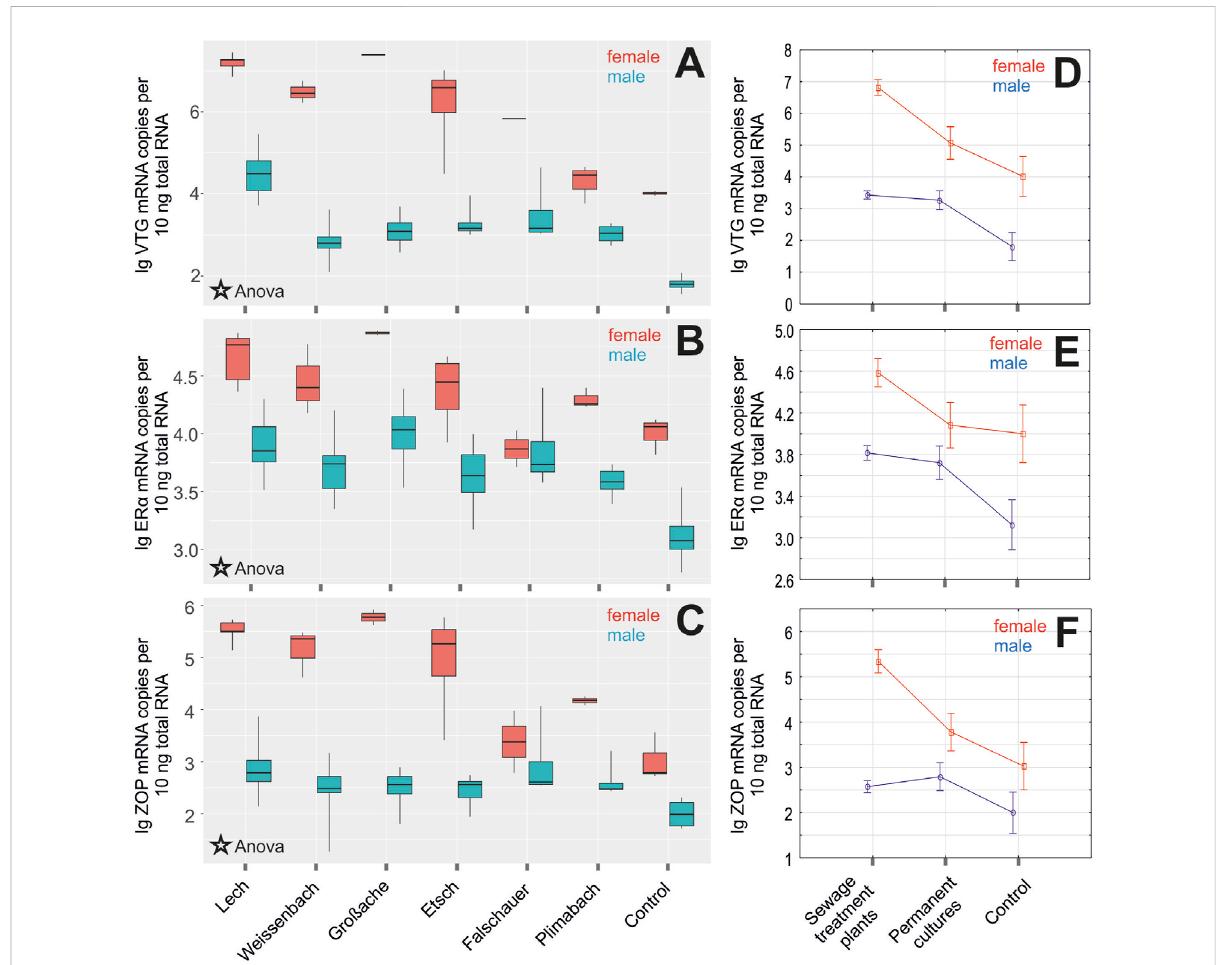
FIGURE 2 Log transformed expression levels (mRNA copy numbers per 10 ng total RNA) of (A) vitellogenin (VTG) (ANOVA; p = 0.0004), (B) estrogen receptor α (ER α ) (ANOVA; p = 0.0006), (C) zona pellucida (ZOP) (ANOVA; p = 0.0002), in liver tissues of male (turquoise) and female (red) individuals of C. gobio ( C. gobio ) at the respective sampling rivers. Combined data of expression levels of (D) VTG, (E) ER α , (F) ZOP in liver tissues of male (blue) andfemale(red)individualsof C.gobio .Signi fi cantdifferencesofmRNAexpressionbetweenmalesandfemaleswerecon fi rmedbyANOVA( p ≤ 0.001) and are indicated with